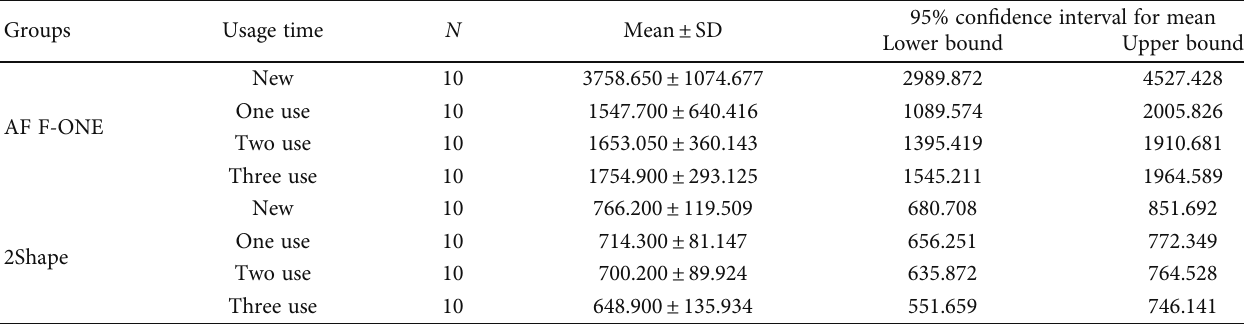
Table 1: Descriptive statistics analysis of both groups.